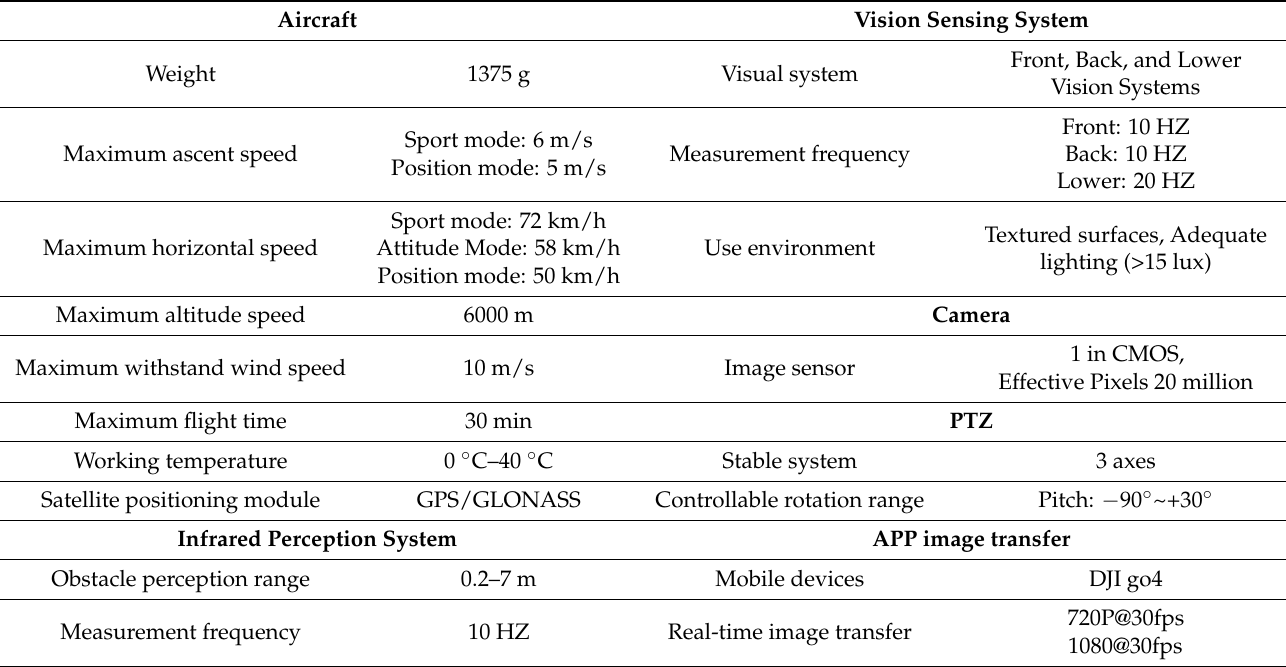
Table 9. Main parameters of UAV and payload